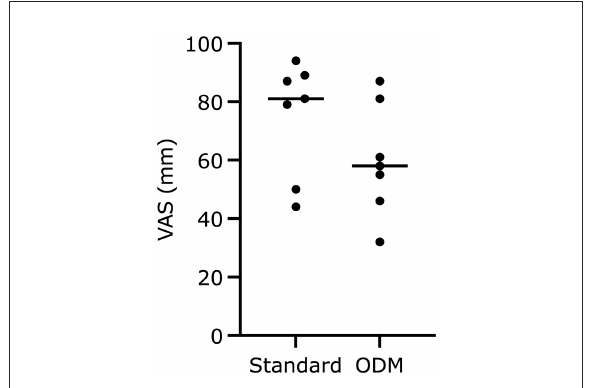
FIGURE4 Scores on the visual analog scale (VAS) regarding the anesthetist’s confidence to understand the dogs’ cardiovascular state at any moment during general anesthesia. The median is marked by a horizontal line,